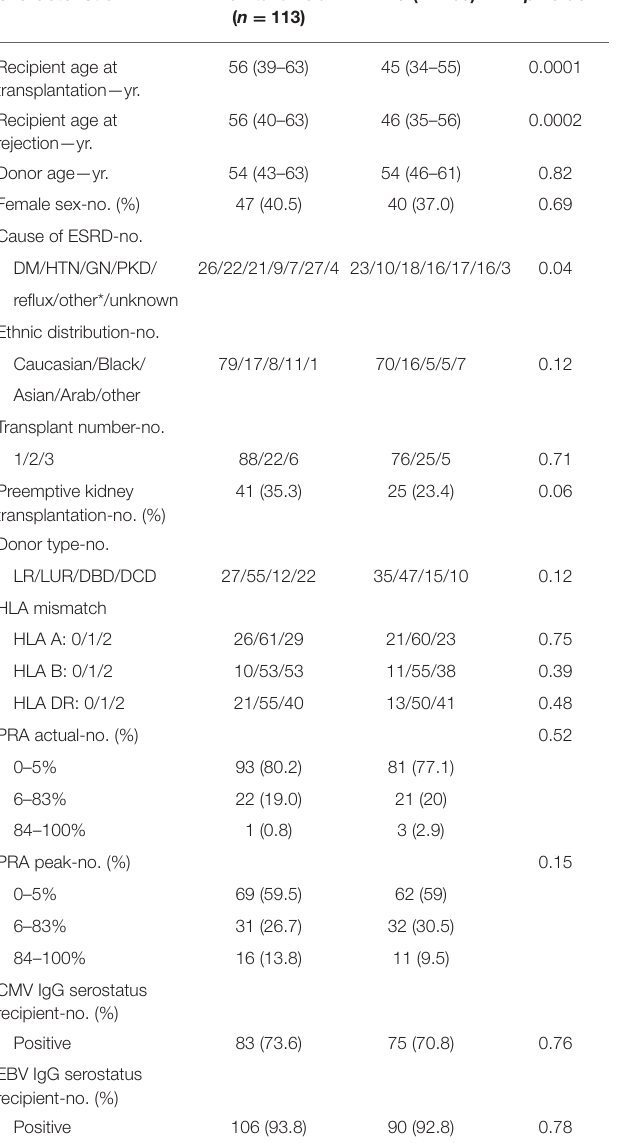
Alemtuzumab rATG ( n = 108) p -value ( n = 113)